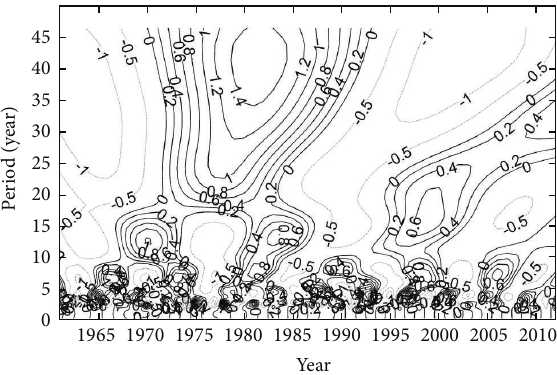
Figure 7: Wavelet analysis of spring precipitation in South China.